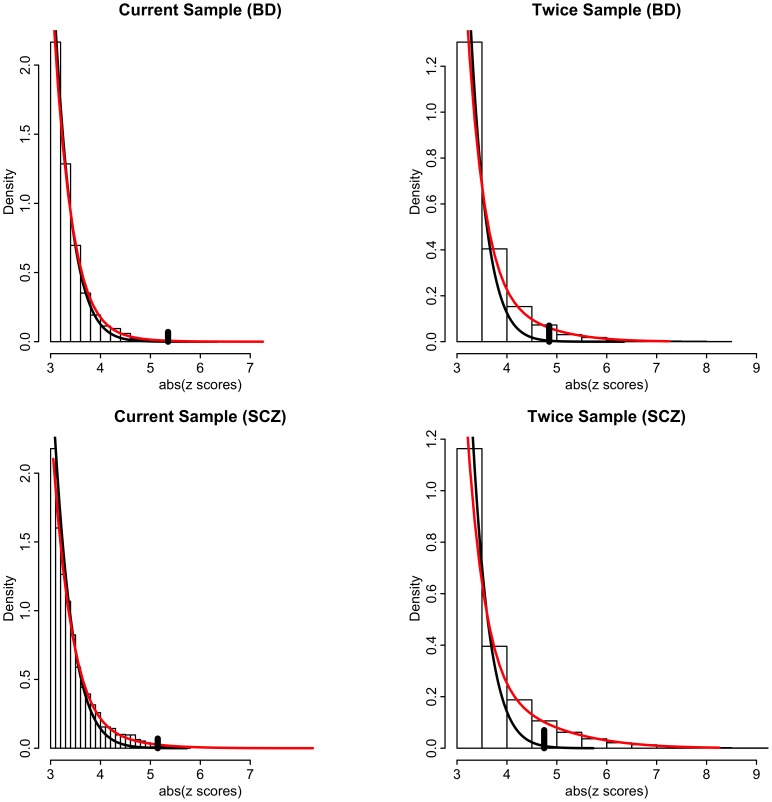
Histograms of absolute z-scores for bipolar disorder (BD, top panels) and schizophrenia (SCZ, bottom panels) for z-scores ≥3.Left panels are actual data, whereas right panels are hypothetical realizations from a doubling of effective sample size, generated from mixture model fits of f(z) = π0f0(z)+(1−π0)f1(z) (see Text S1). Black lines are null sub-densities π0f0(z) and red lines are the full mixture densities f(z). The local false discovery rate is the ratio fdr = π0f0(z)/f(z). Vertical black bars in each plot indicate the cut-points where local fdr≤0.05.